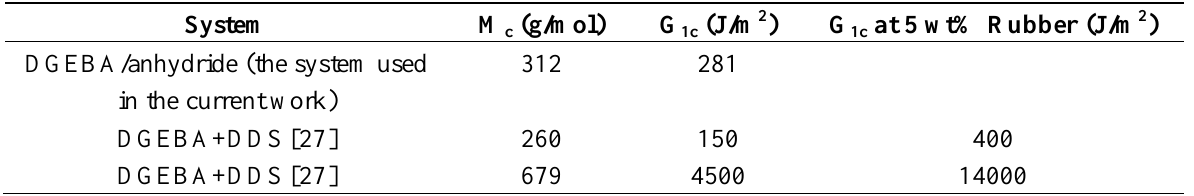
Table 3. A comparison of the toughenability of the epoxy used in this study to some literature systems.